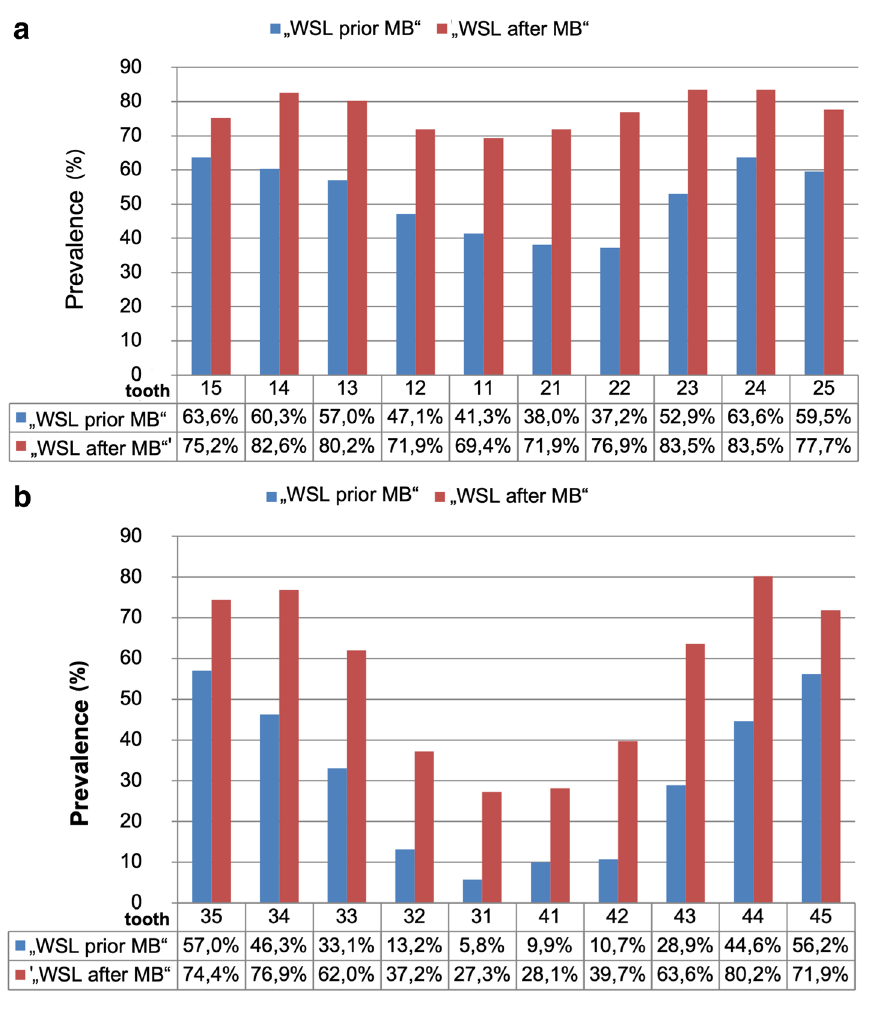
Figure 3. ( a , b ) Bar diagrams describing the prevalence of WSL of upper teeth ( a ) and lower teeth ( b ). The x-axis divides the examined teeth according to the time of their examination (WSL prior to MB; WSL after MB). The y-axis displays the percentage that corresponds to the occurrence of WSL; only the positive results (WSL = 1) were included.